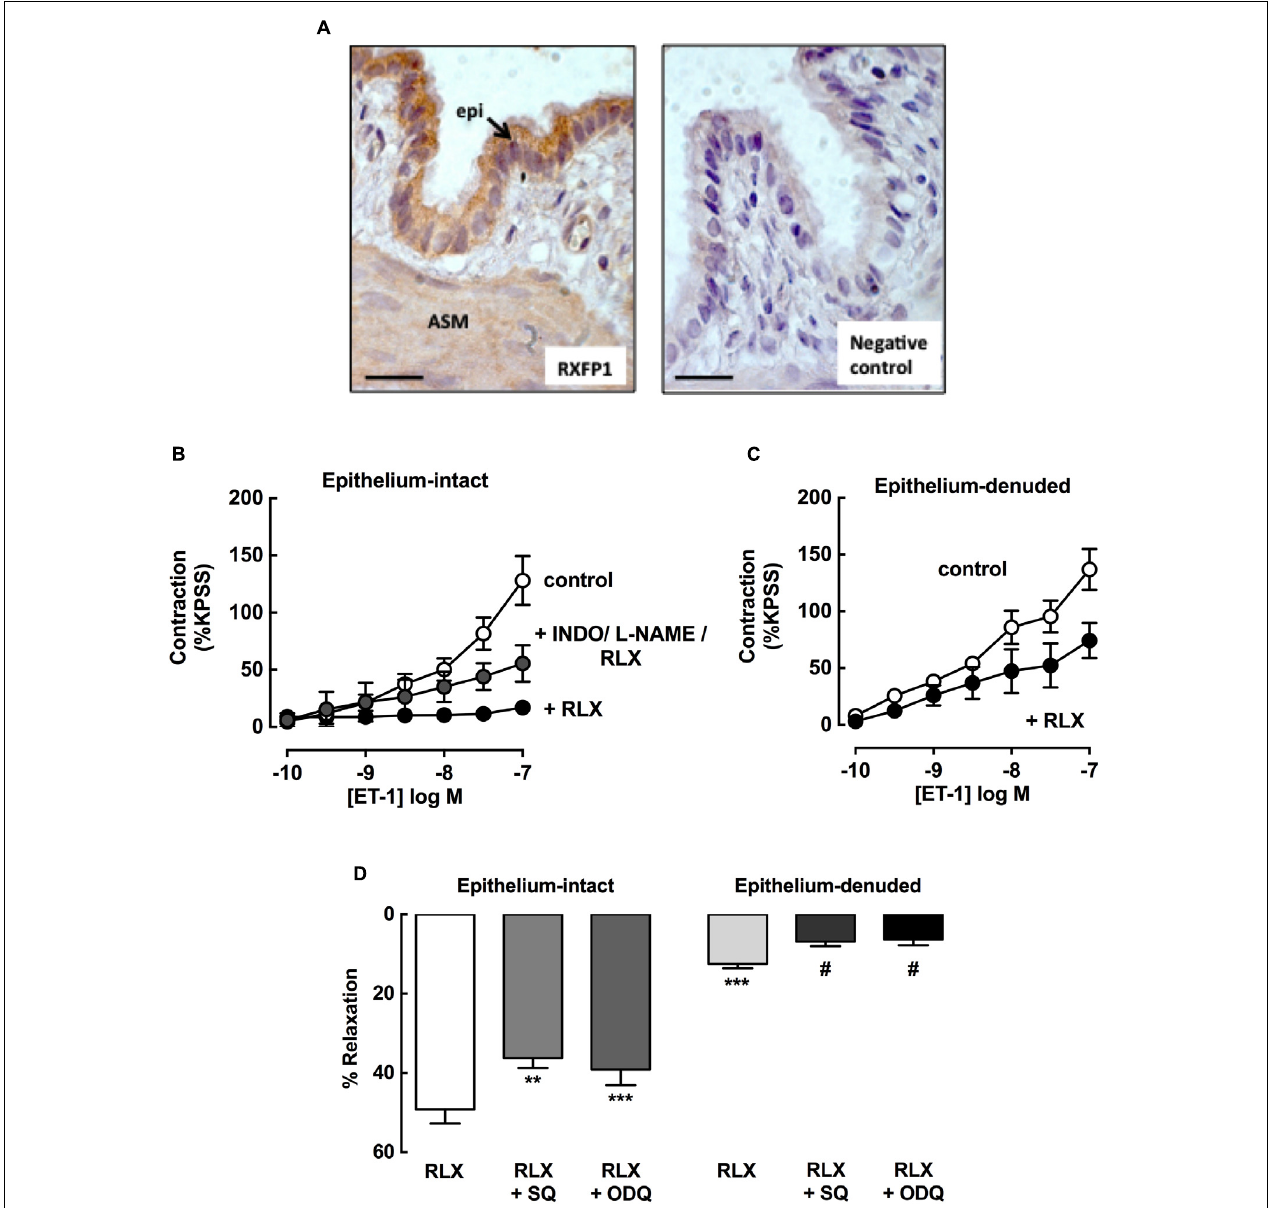
FIGURE 7 | rhRLX acts via epithelial-dependent and -independent mechanisms. RXFP1 protein was localized in rat lungs by immunohistochemistry, and responses to rhRLX (RLX) in epithelial-intact and -denuded trachea were compared in the absence and presence of specific inhibitors. (A) Immunoreactive RXFP1 is predominantly localized in airway epithelium (epi) and smooth muscle (ASM). Contraction to ET-1 in (B) intact trachea under control conditions, and with RLX (0.1 µ M) in the absence and presence of INDO (3 µ M) + L-NAME (100 µ M) and (C) in denuded trachea in the absence and presence of RLX (0.1 µ M). Responses to ET-1 are expressed as a % of KPSS contraction. (D) Responses to RLX (0.1 µ M) in intact and denuded trachea in the absence or presence of SQ22536 (10 µ M) or ODQ (1 µ M), expressed as % relaxation of MCh pre-contraction. Data is expressed as mean ± SEM ( n = 4–8 per group). ∗∗ P < 0.01, ∗∗∗ P < 0.001, vs. RLX in intact trachea, # P < 0.05 vs. RLX in denuded